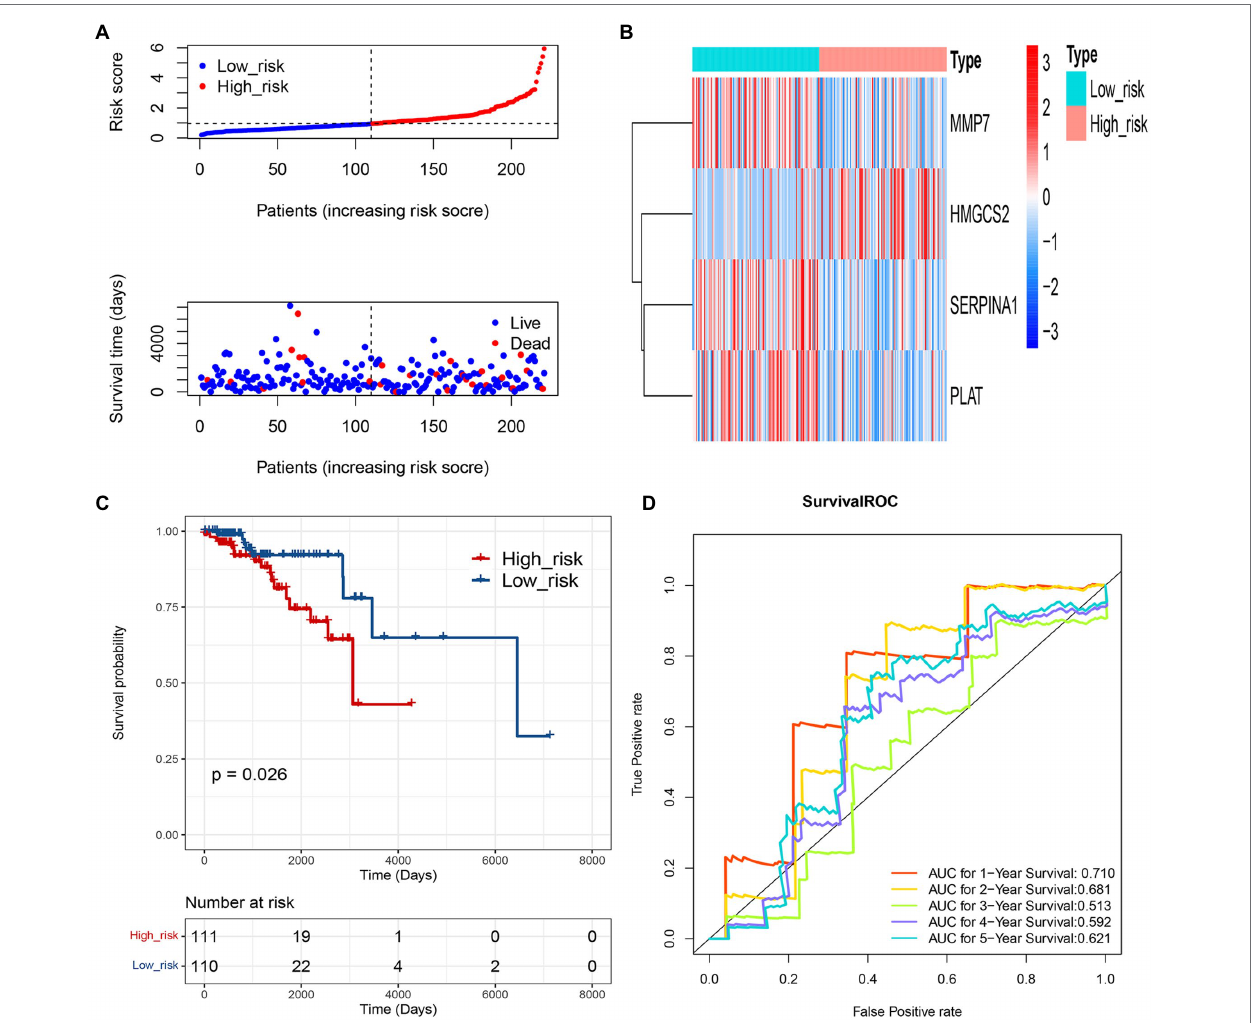
FIGURE 5 | Validation of the prognostic gene signature of 4 COAGULATION-related genes. (A) Risk curve and its corresponding scatter plots in the validation set. (B) Heat map of risk model genes in the validation set. (C) Kaplan–Meier survival curves of high- and low-risk groups in the validation set. Red represents high risk, and blue represents low risk. (D) Survival ROC curves for 1-, 2-, 3-, 4-, and 5-year